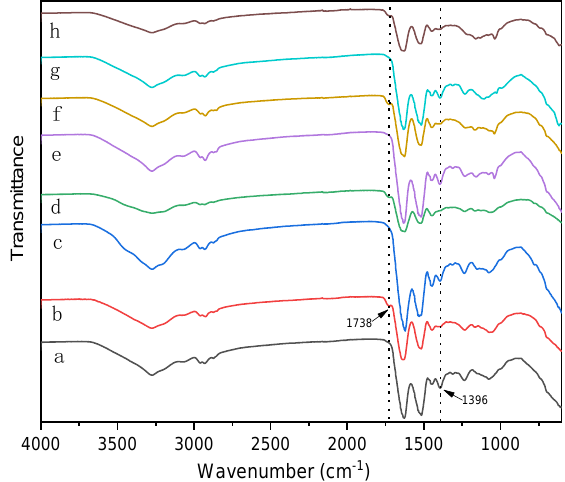
Figure 7. The denaturation and crosslinking mechanism of soy protein molecule.